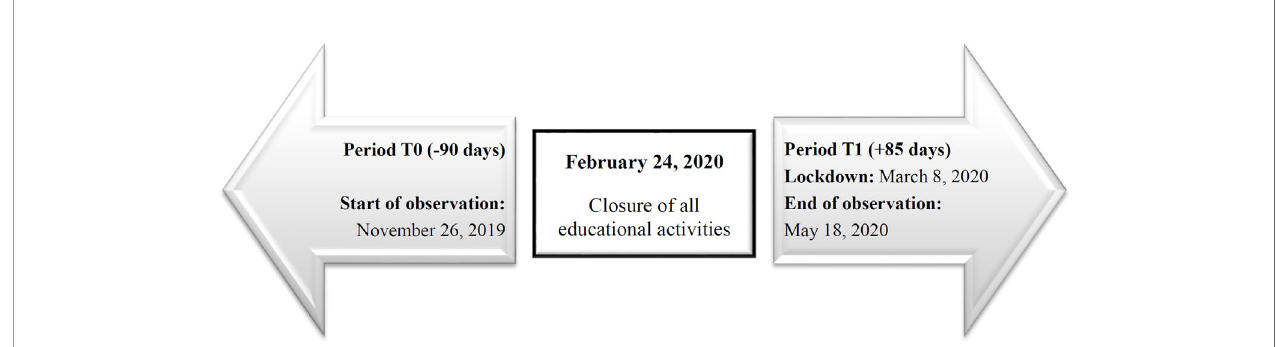
FIGURE 1 | Timeline of